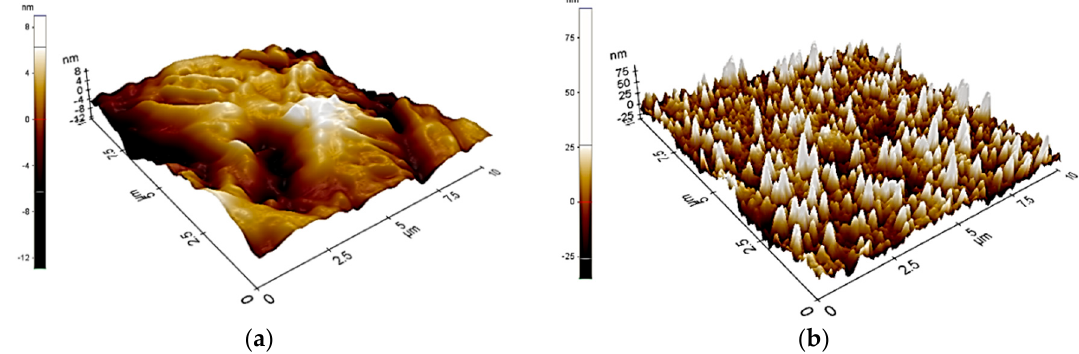
Figure 3. Examples surface topography analysis ( a ) 3D view of atomic force microscopy (AFM) scan from 10 × 10 µm 2 M1; ( b ) 3D view of AFM scan from 10 × 10 µm M2.